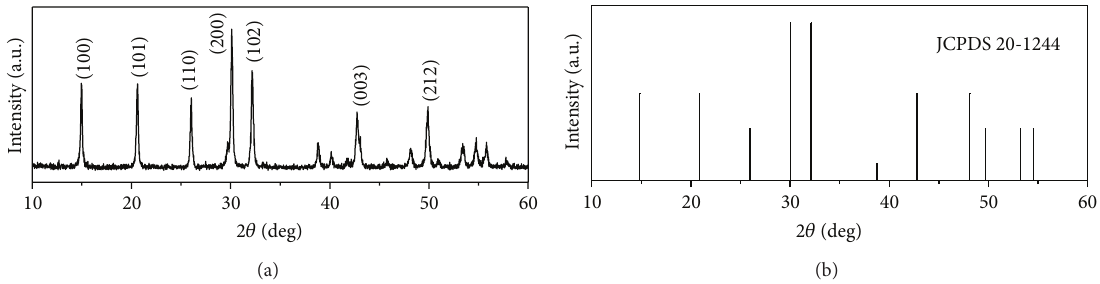
Figure 1: XRD patterns of bundle-shaped TbPO 4 ⋅ H 2 O nanorods (a) and standard data of bulk TbPO 4 ⋅ H 2 O ((b), JCPDS card 20-1244).